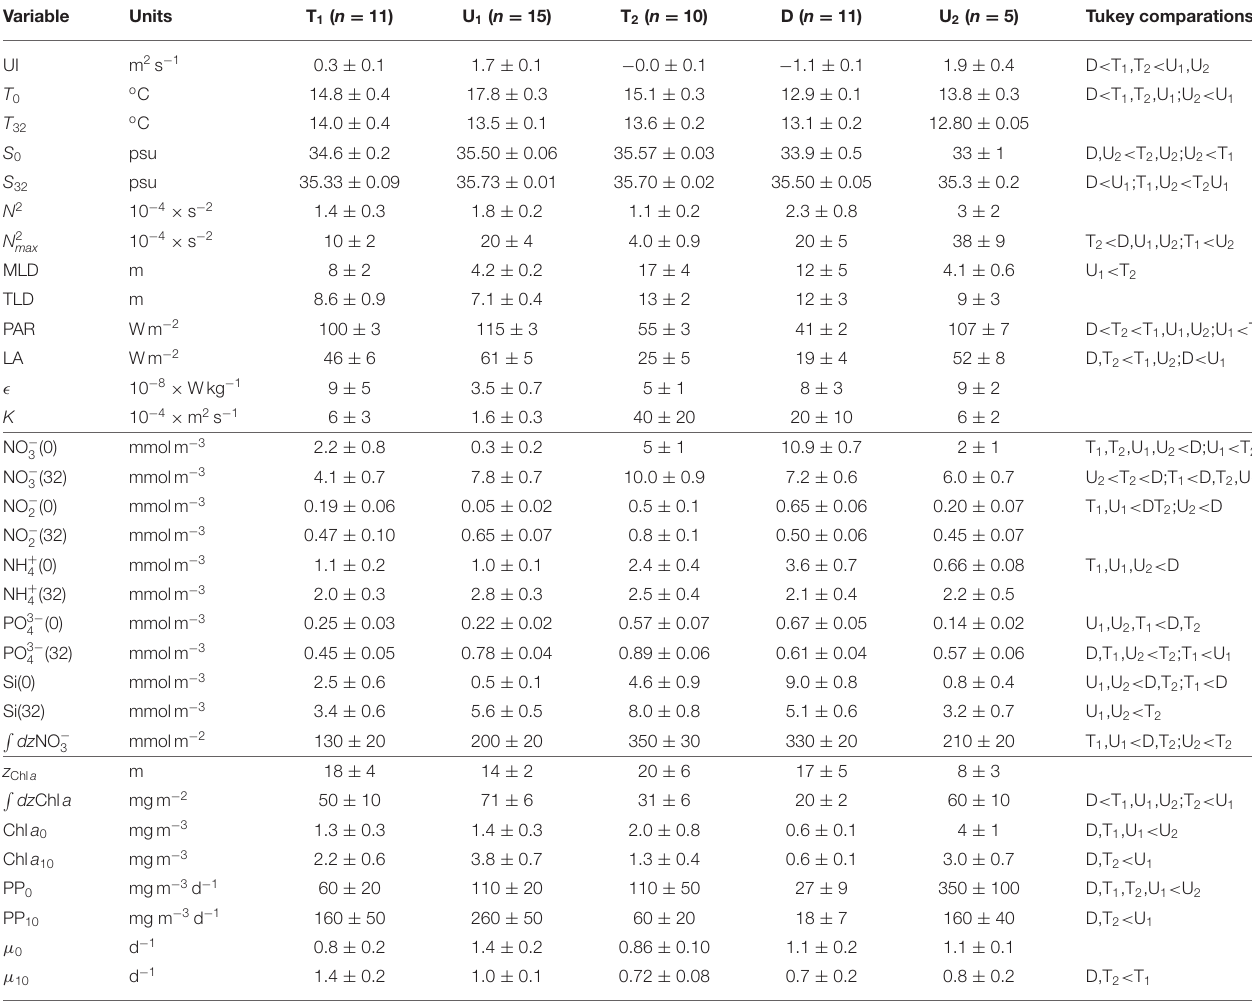
TABLE 1 | Mean ± standard uncertainty of the mean for selected variables averaged on each time periods.